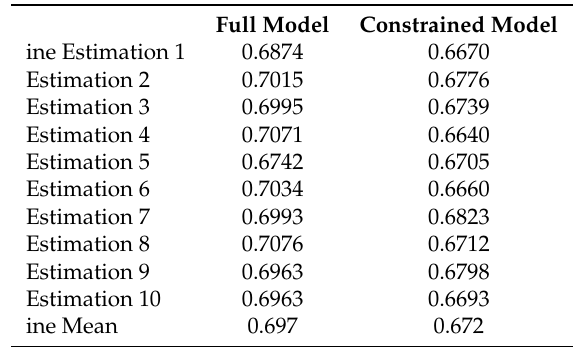
Figure 1. Civil war onset: GDP per capita and political globalisation. Note: Graph shows average marginal effects of GDP per capita t-1 (ln) conditional on political globalisation t-1 , while holding all other covariates constant at their means. The horizontal bar signifies 90 percent confidence intervals. The dashed horizontal line marks a marginal effect of 0. Table 3. Out-of-sample prediction: 4 fold